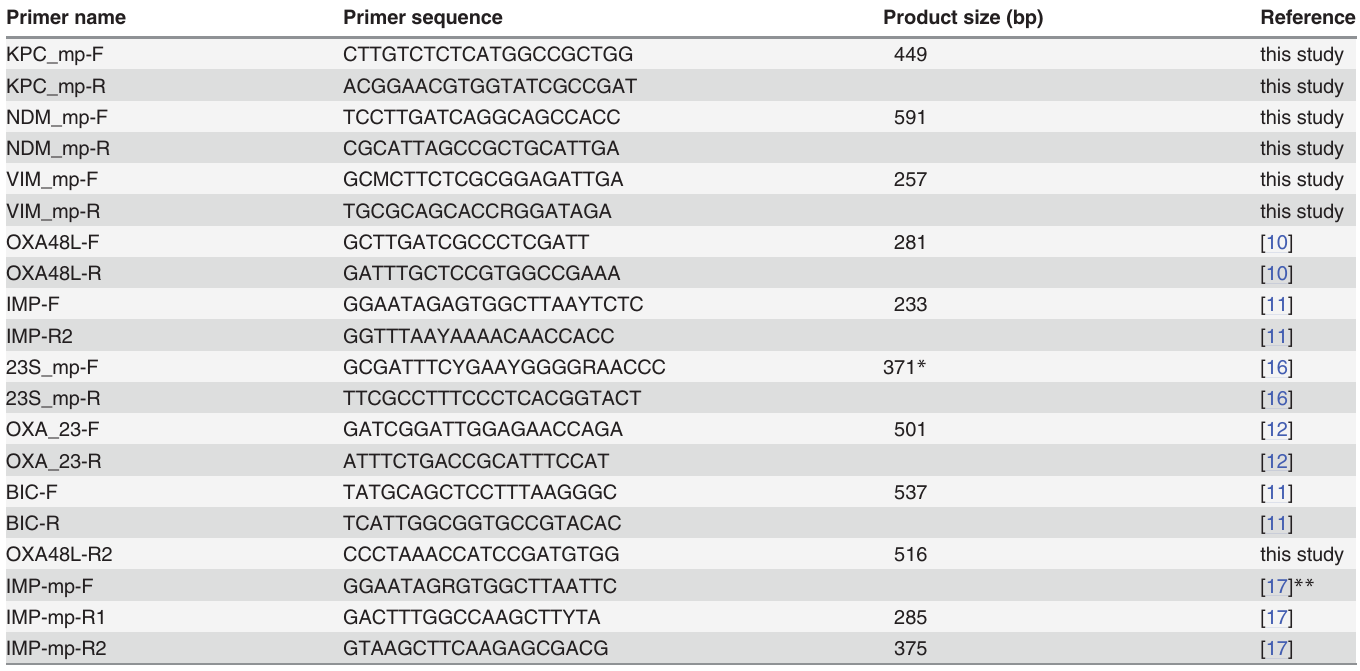
Table 4. Primers used for PCR detection of carbapenemase encoding genes. Primer